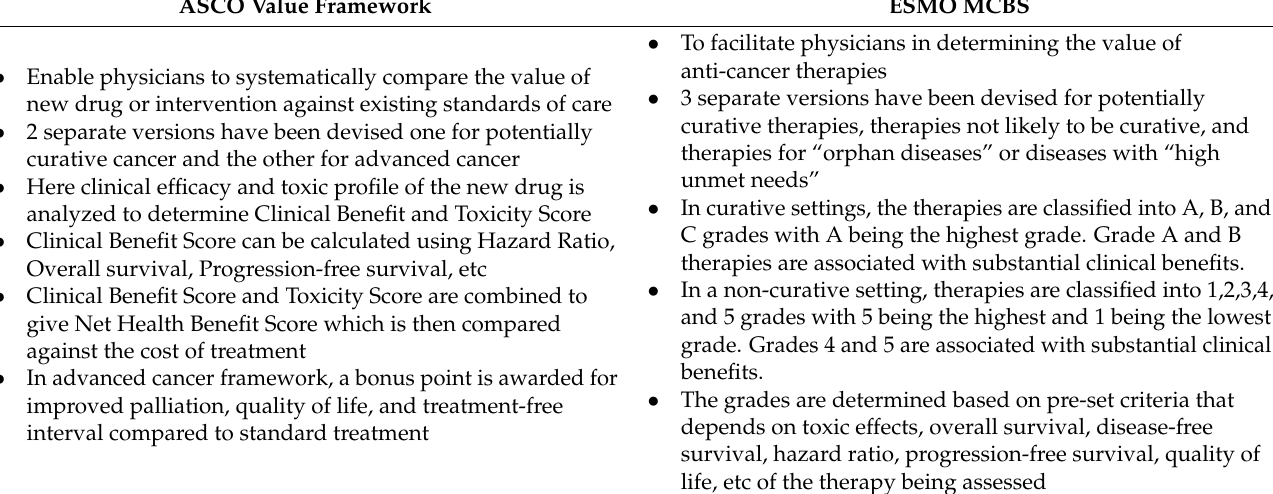
Table 1. Tools to assess value of systemic therapy in